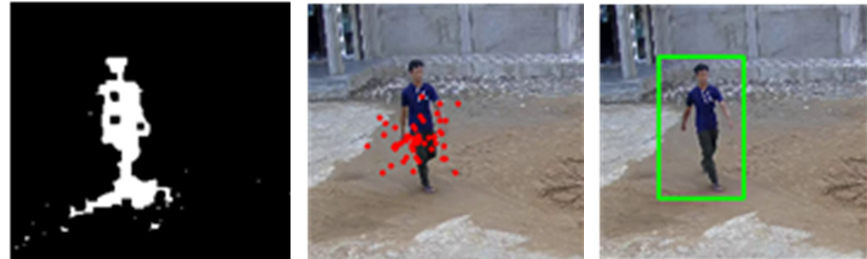
Figure 8. Tracking with particle filter.